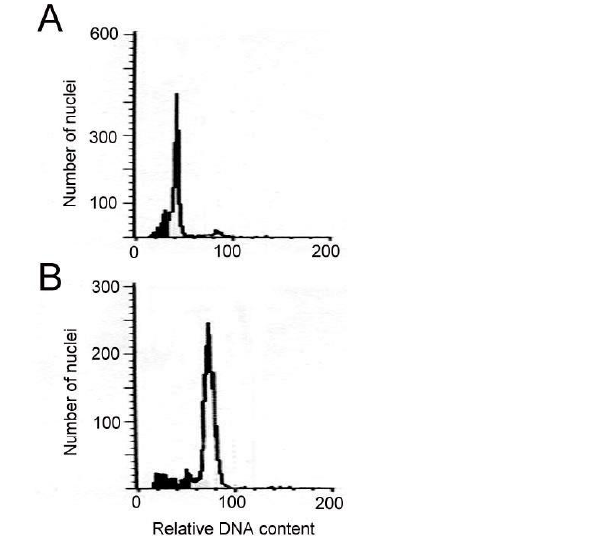
Figure 2. Flow cytometric analysis of the plantlets of Salvia miltiorrhiza . ( A ) Diploid. ( B ) Tetraploid.